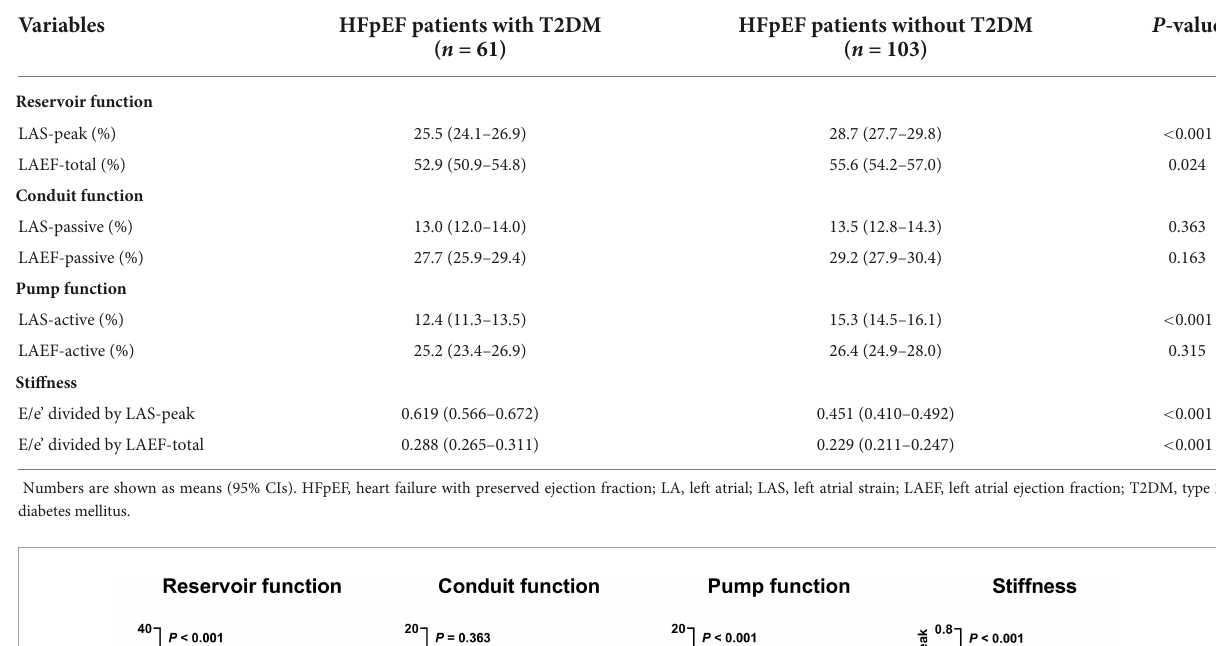
TABLE 2 Unadjusted comparisons of LA function and stiffness between HFpEF patients with and without T2DM.